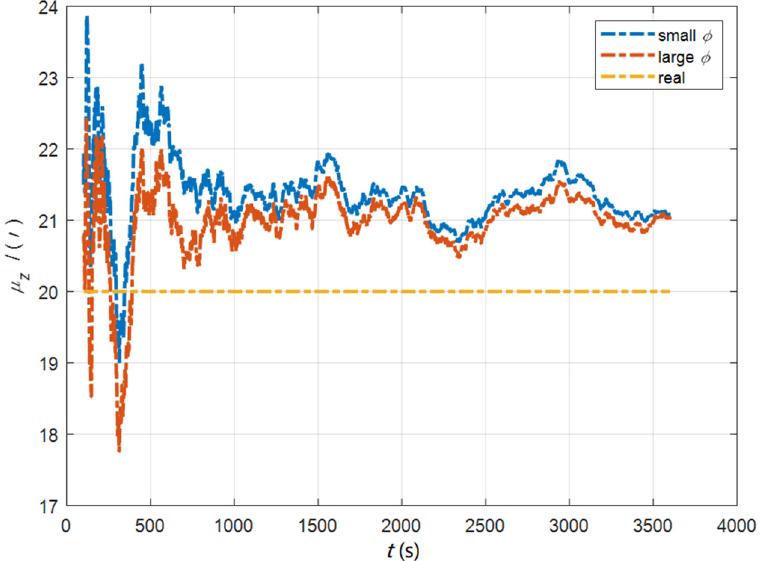
μ in the case of large and small initial misalignment angles. Figure 28. The curves of µ z in the case of large and small initial misalignment μ z in the case of large and small initial misalignment angles. z